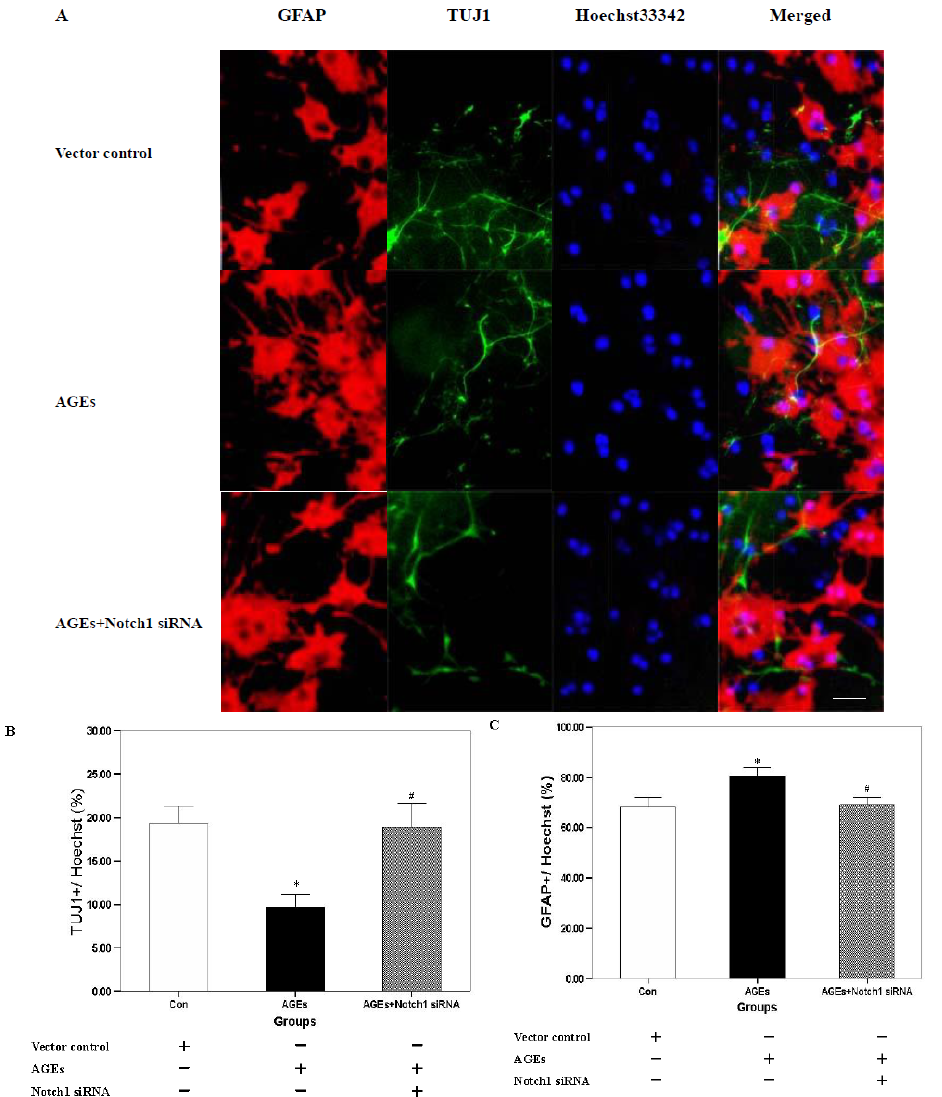
Figure 2. AGEs stimulated the differentiation of cultured neurospheres into astrocytes by inhibiting neuronal differention through Notch-Hes1 pathway. ( A ) NSCs derived from SGZ could generate into neurons (TUJ1) and astrocytes (GFAP) after seven days of culture in differentiation medium. Scale bar, 50 μ m; and ( B , C ) 400 μ g/mL AGE-BSA induced a significant decrease in the proportion of TUJ1 cells and increase in the numbers of GFAP-immunoreactive cells with astrocytic morphology (* p < 0.05, n = 3). All these values were reversed after Notch1 -silenced NSCs were incubated with 400 μ g/mL AGE-BSA ( # p < 0.05, n =